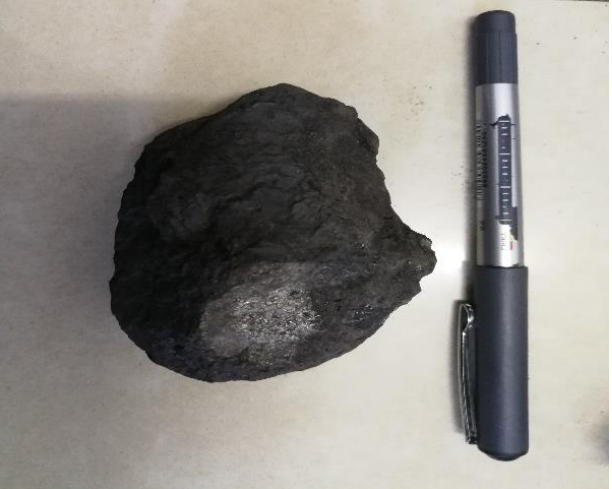
Figure 3. Pyrite nodules formed by hydrothermal fluid in the No. 8 coal seam of the Carboniferous in the Datong Coalfield.